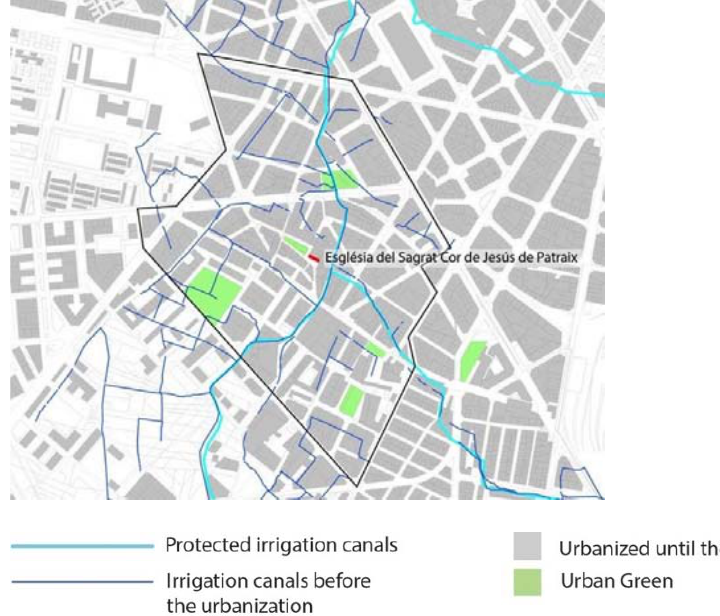
Figure 25. The transition of the irrigation canals and urban greens in Patraix.